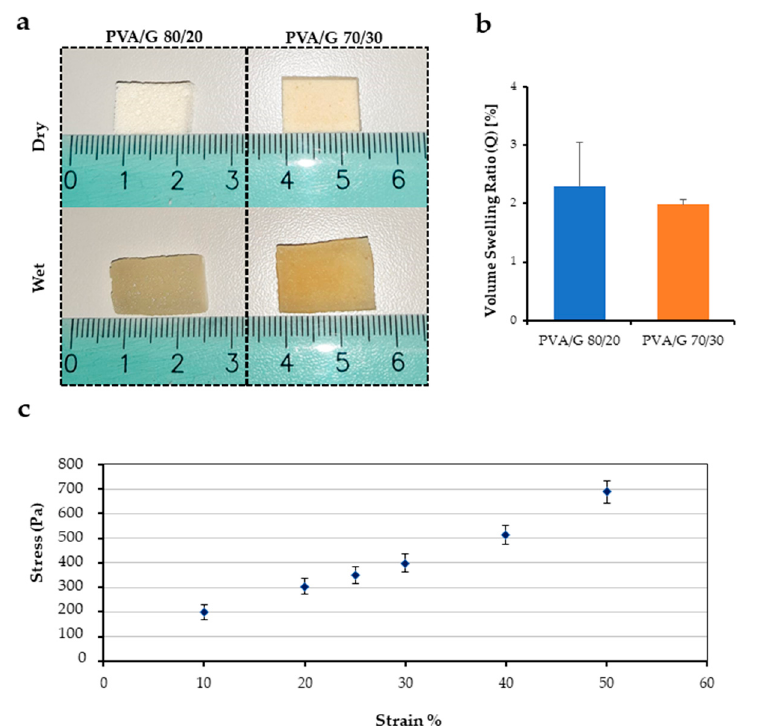
Figure 2. Results of physico-mechanical analysis of PVA/G sponges: ( a ) photograph of PVA/G 80/20 and PVA/G 70/30 ( w /w%) sponges dry and wet; ( b ) bar graph showing the volume swelling ratio for PVA/G 80/20 and 70/30 ( w /w%); ( c ) point graph displaying the mechanical behavior of wet PVA/G 80/20 ( w /w%) sponge under compression.